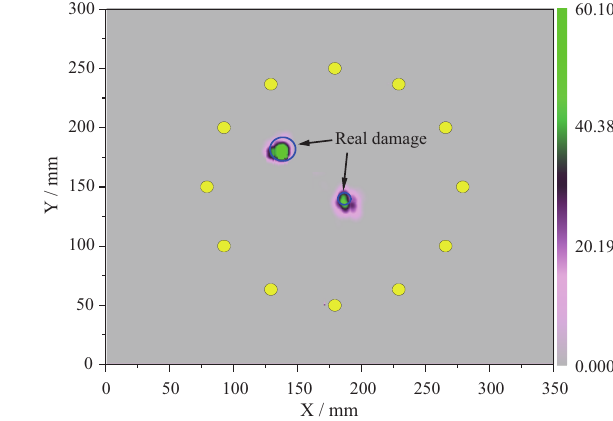
Fig. 15. Damage indices of the composite laminate with two damages.